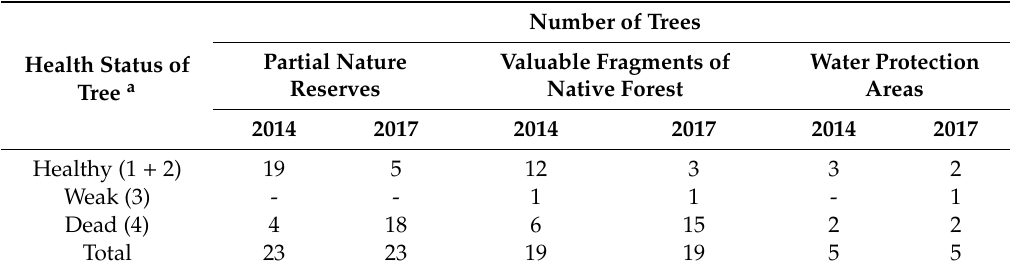
a Health status categories from Table 1. Healthy—spruces not showing visible symptoms of their decline; weak—spruces with dead or dying branches in the crown; and dead—most of the needles fallen or brownish if still on the